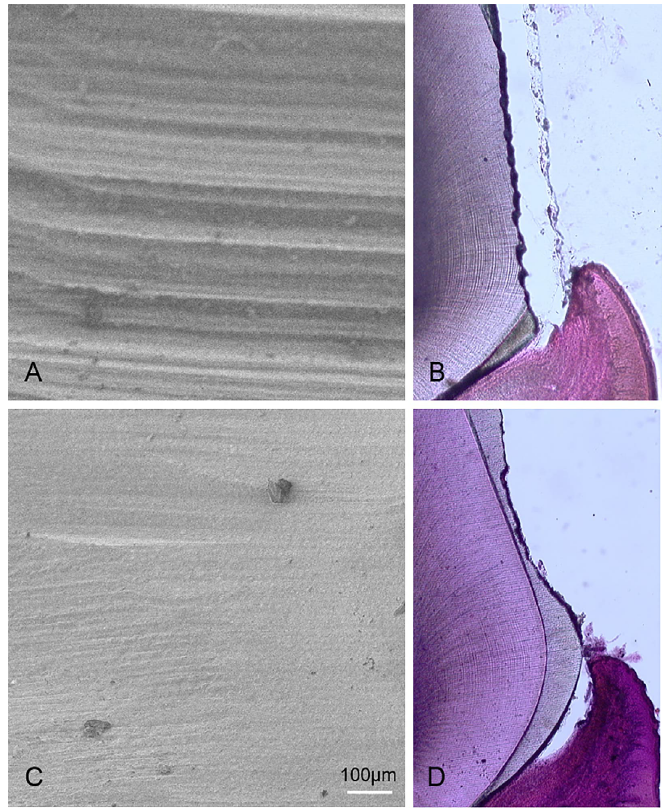
Figure 2- Scanning electron microscope (SEM) and hematoxylin and eosin staining observations of the prepared tooth surfaces. The cutting surface was observed using an SEM (A, C) and hematoxylin and eosin staining (B, D). A, B: Irregular and lateral stripes are visible in the turbine group. C, D: The surfaces are flat and smooth in the ultrasonic group